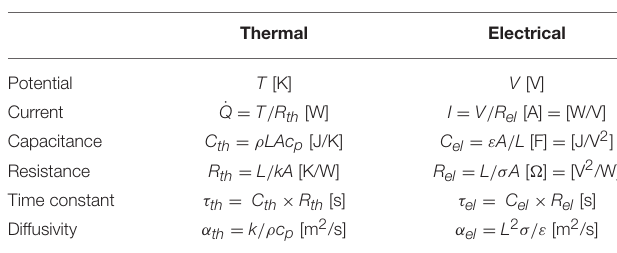
TABLE 1 | Properties and characteristics in the thermal and electrical analogy based on an energy flow in a rectangular solid with length L [m] and cross-sectional area A [m 2